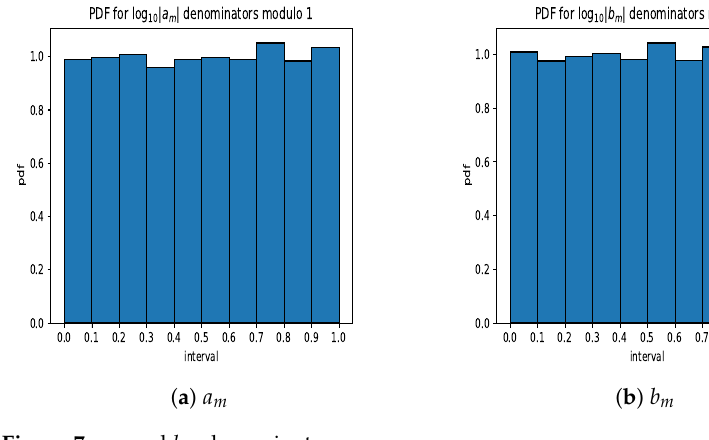
Figure 7. a m and b m denominators.